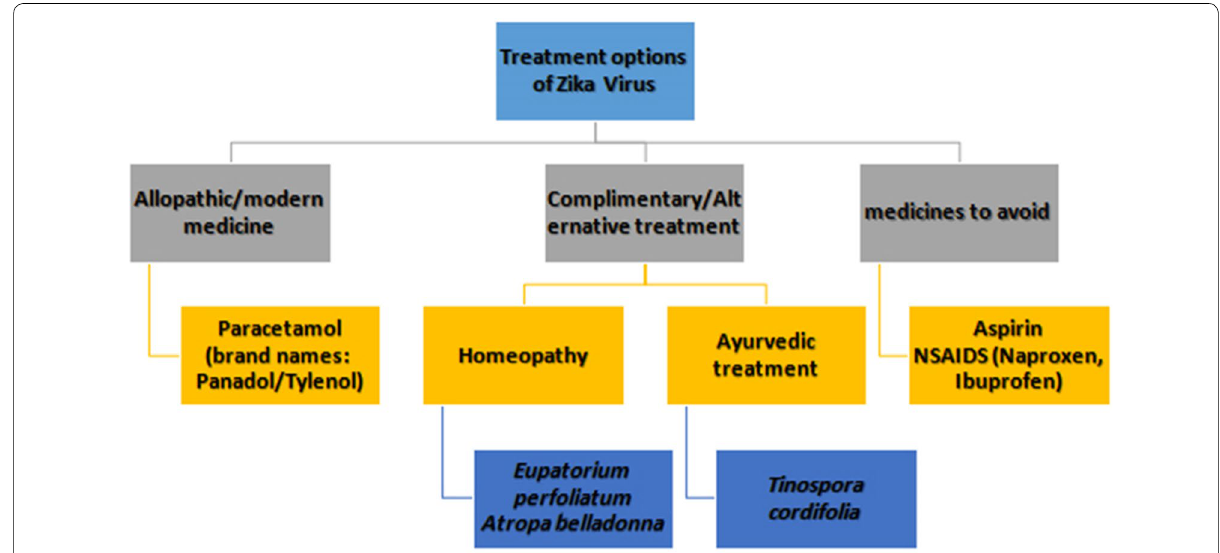
Fig. 6 Schematic representation of possible ZIKV